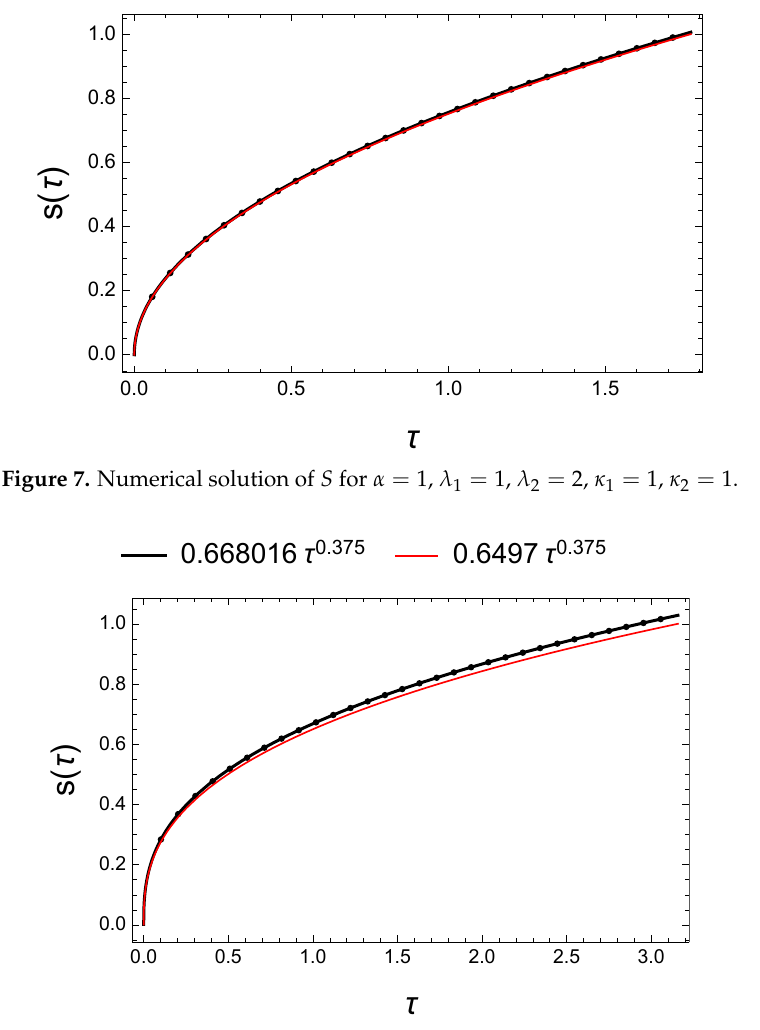
Figure 8. Numerical solution of S for α = 0.75, λ 1 = 1, λ 2 = 2, κ 1 = 1, κ 2 =